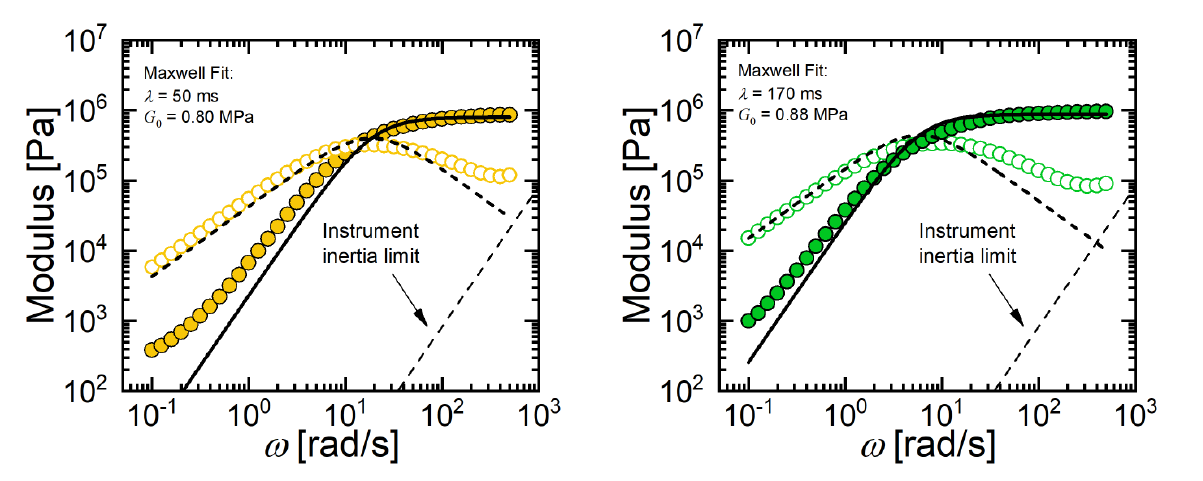
Figure A4: The same data shown in Figure A3 is fit to a single-model Maxwell model, represented with the solid G ′ and dashed G ′′ black lines. Fit parameters are shown for each putty. There is disagreement between the model and the experimental data at low frequencies in the elastic modulus G ′ and high frequencies in the viscous modulus G ′′ .